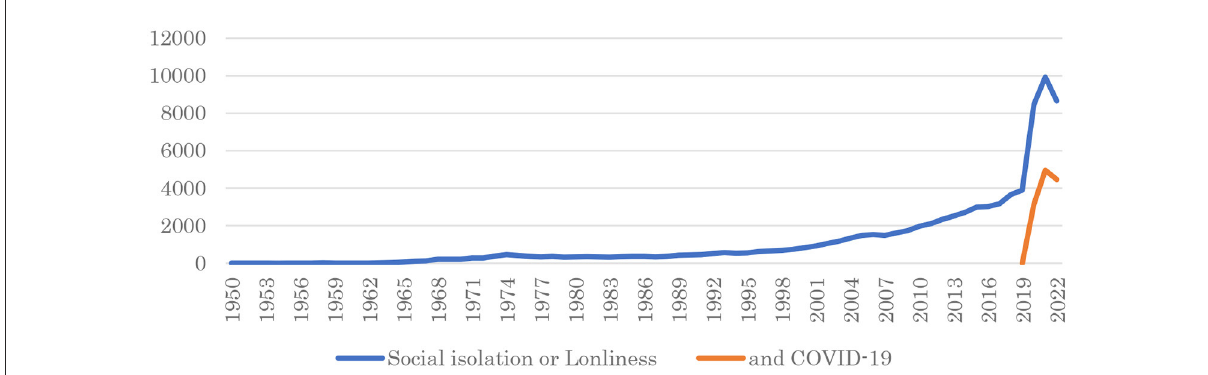
FIGURE1 The number of publications about social isolation and loneliness by year. Data were obtained from Scopus (https://www.scopus.com/; accessed on 2022/11/4) through searches for “social isolation” or “loneliness” (blue line) and “social isolation” or “loneliness” plus “COVID-19” (orange line). The figures for 2022 were estimated from the numbers as of